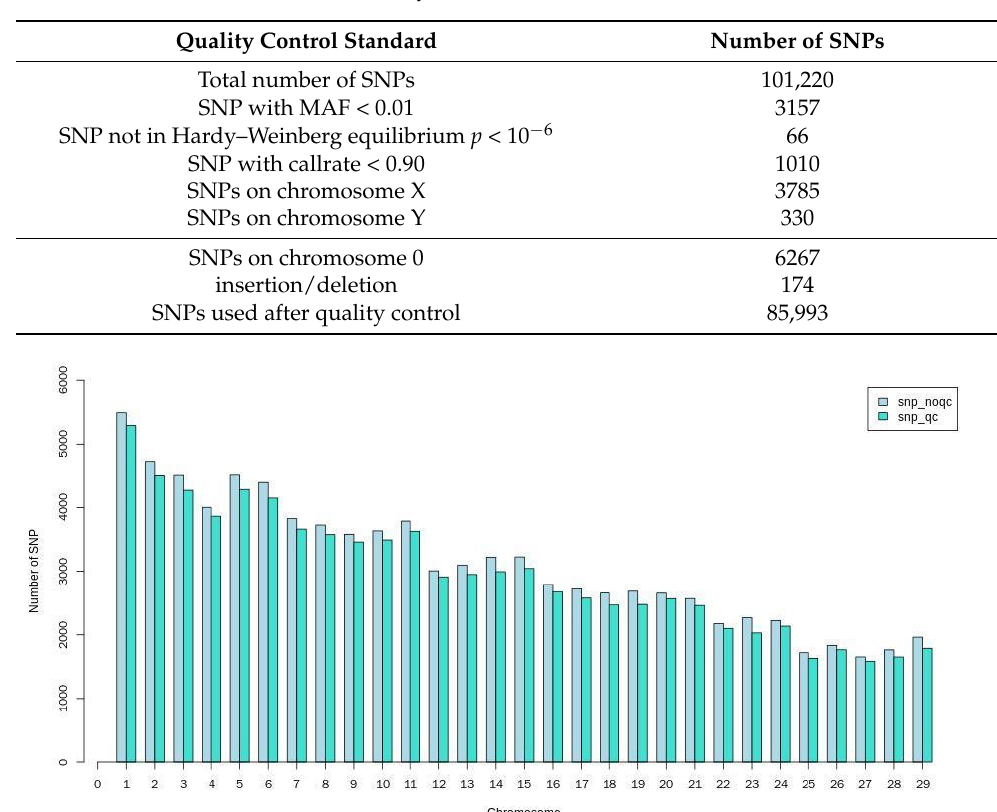
Figure 1. DNA gel electrophoresis.